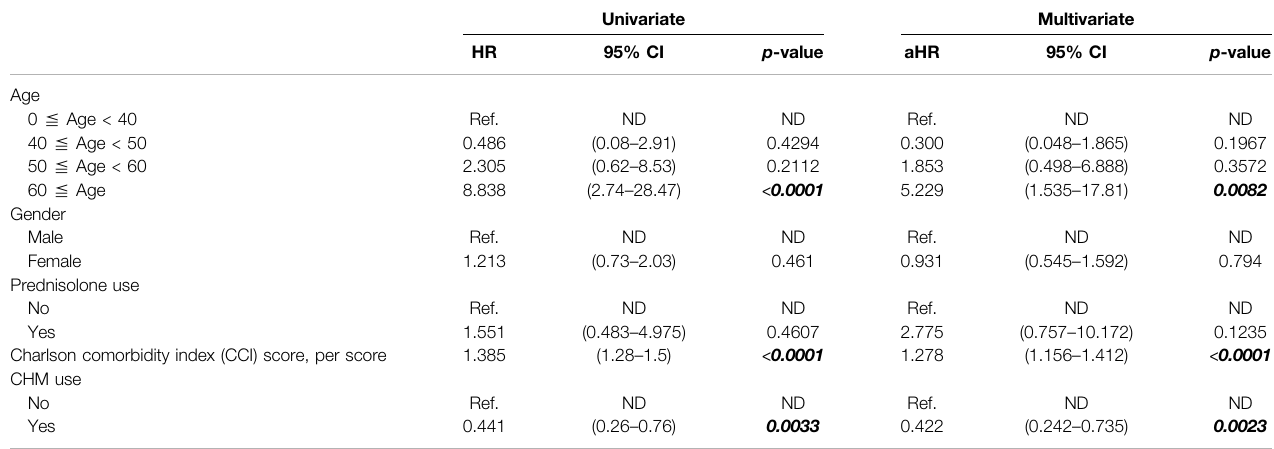
TABLE 2 | Cox proportional hazard models for overall mortality in patients with pemphigus in